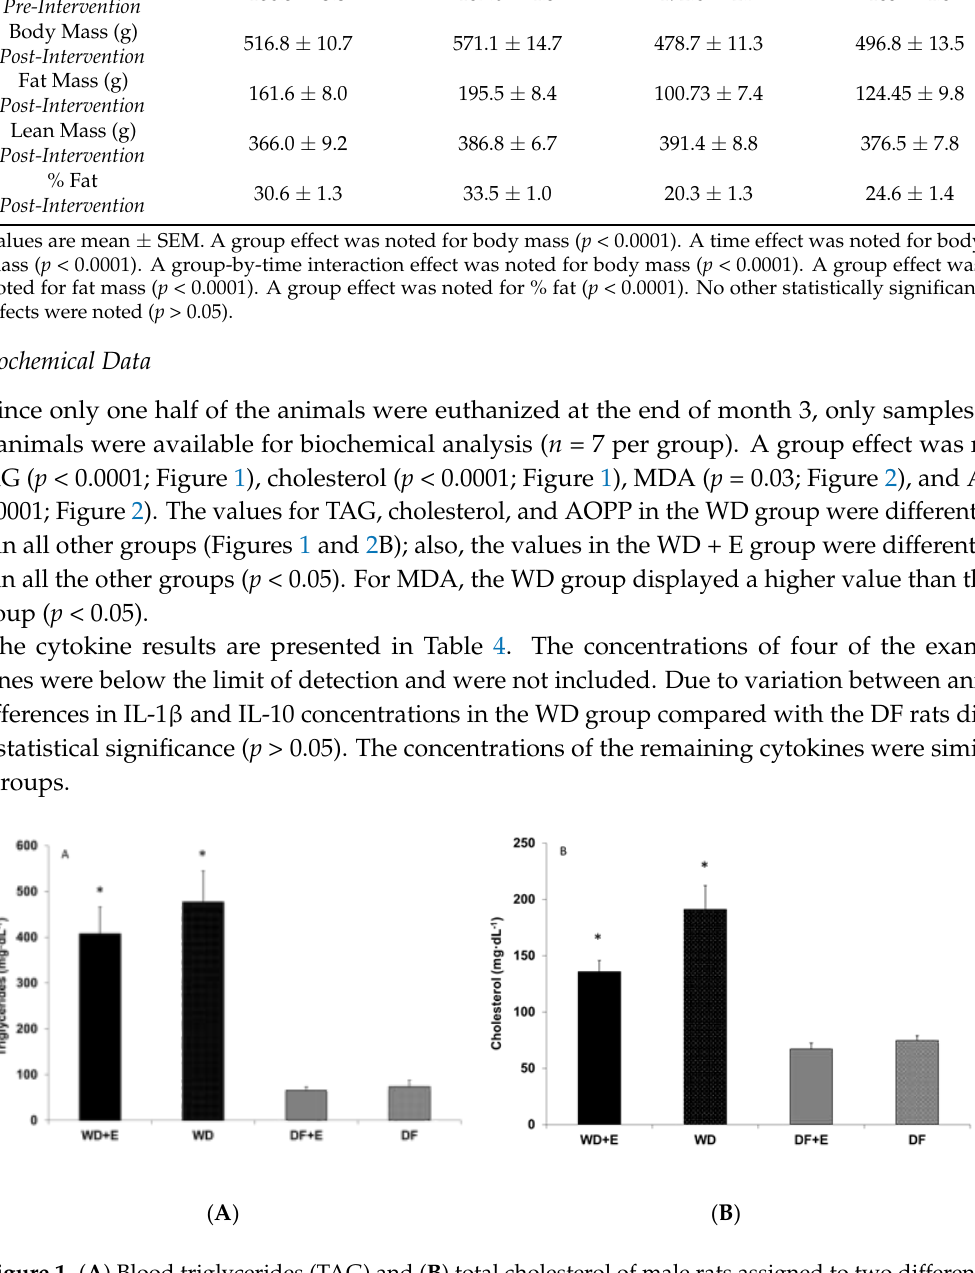
Figure 1. ( A ) Blood triglycerides (TAG) and ( B ) total cholesterol of male rats assigned to two different diets with and without exercise. Values are mean ± SEM. *A group effect was noted for TAG ( p < 0.0001) and cholesterol ( p < 0.0001). For TAG and cholesterol, the Western Diet (WD) group was different from all the other groups, and the Western Diet + Exercise (WD + E) group was different from all the other groups ( p < 0.05).